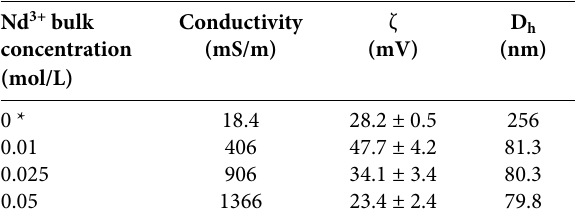
Table 1: Zeta potential (ζ) and hydrodynamic diameter (D h ) of MNPs after adsorption of Nd 3+ ions from aqueous solution with different bulk concentration of Nd(NO 3 ) 3